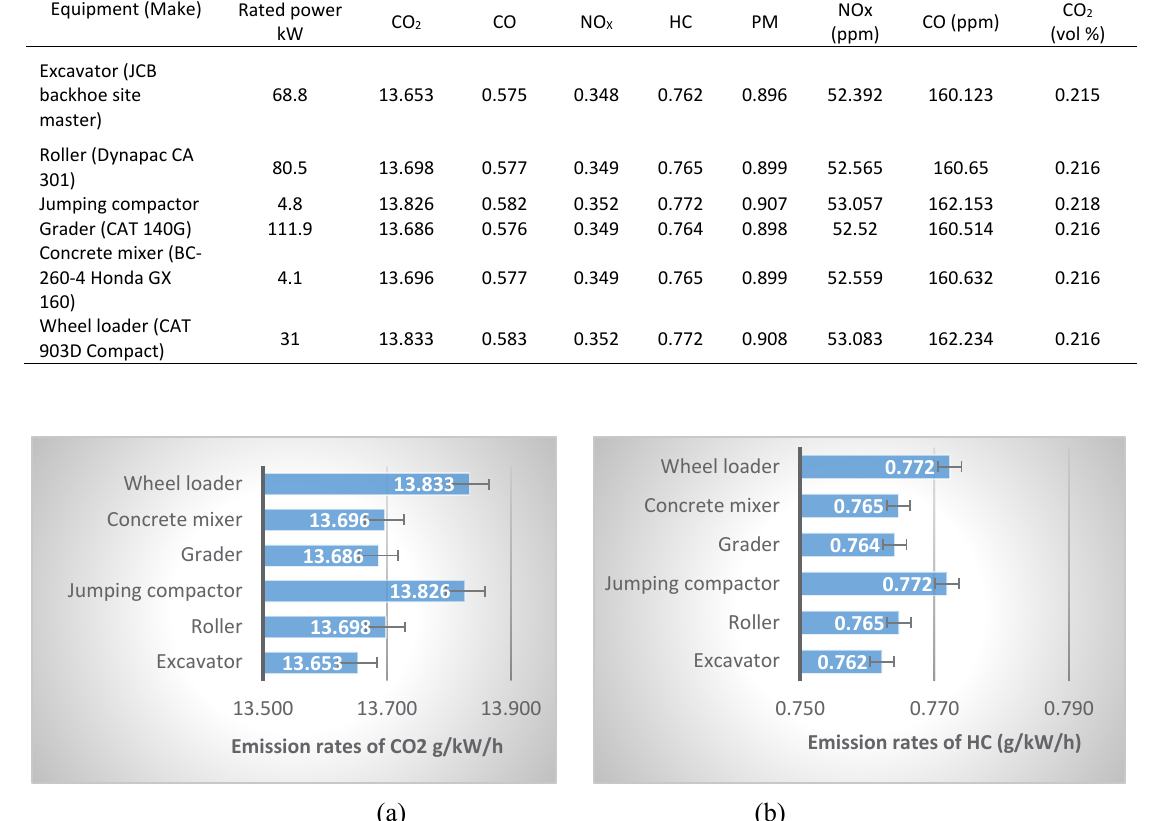
Fig. 5: Emissions rates of GHGs for sampled in g/kW/h; a) CO2; b) HC